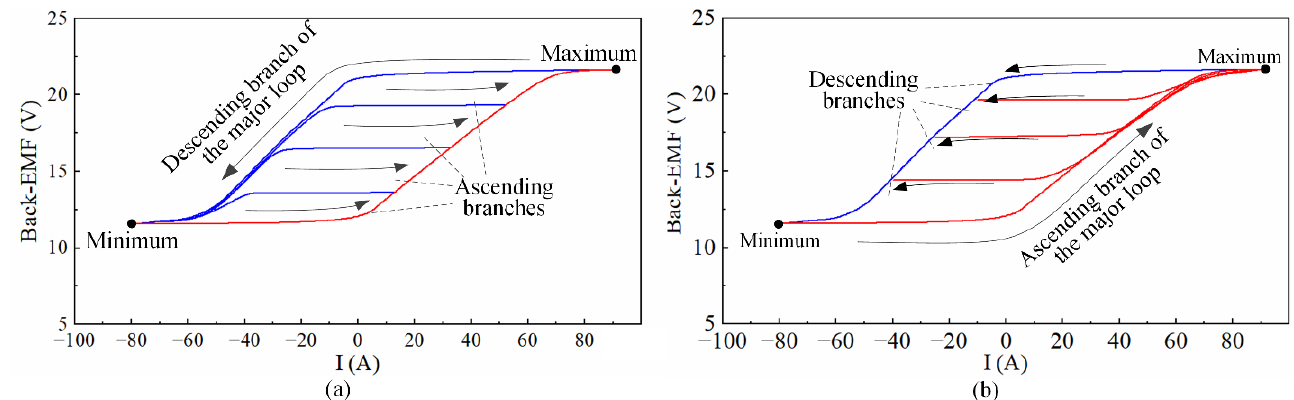
Figure 16. Back-EMF hysteresis loops of the proposed machine: ( a ) Magnetizing process; ( b ) De- magnetizing process.